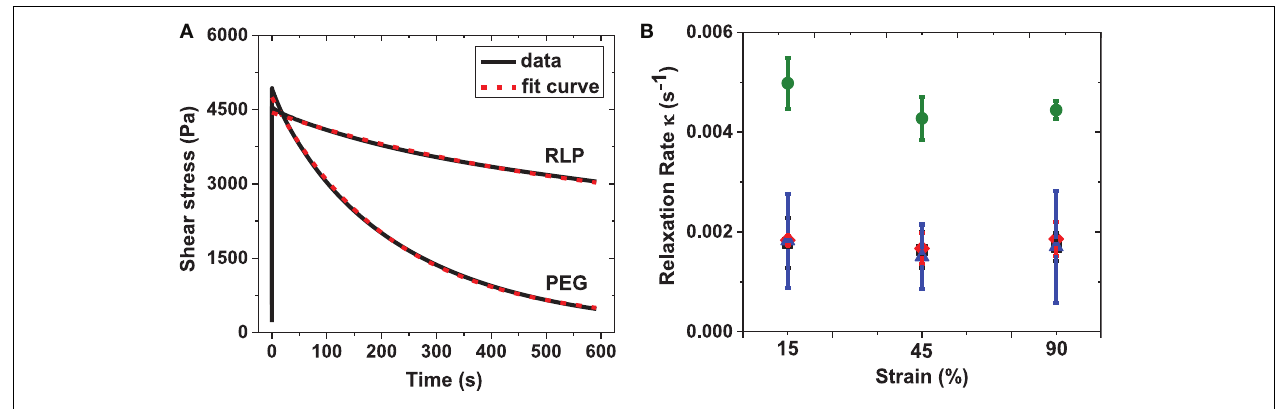
FIGURE 6 | (A) Representative fitting curves for 10 wt% RLP and 10 wt% 4-arm PEG hydrogels; (B) summary of relaxation rate of 5 wt% (square), 10 wt% (diamond) and 20 wt% (triangle) RLP and 10 wt% 4-arm PEG (circle) hydrogels at 15, 45, and 90% constant strains. The stress